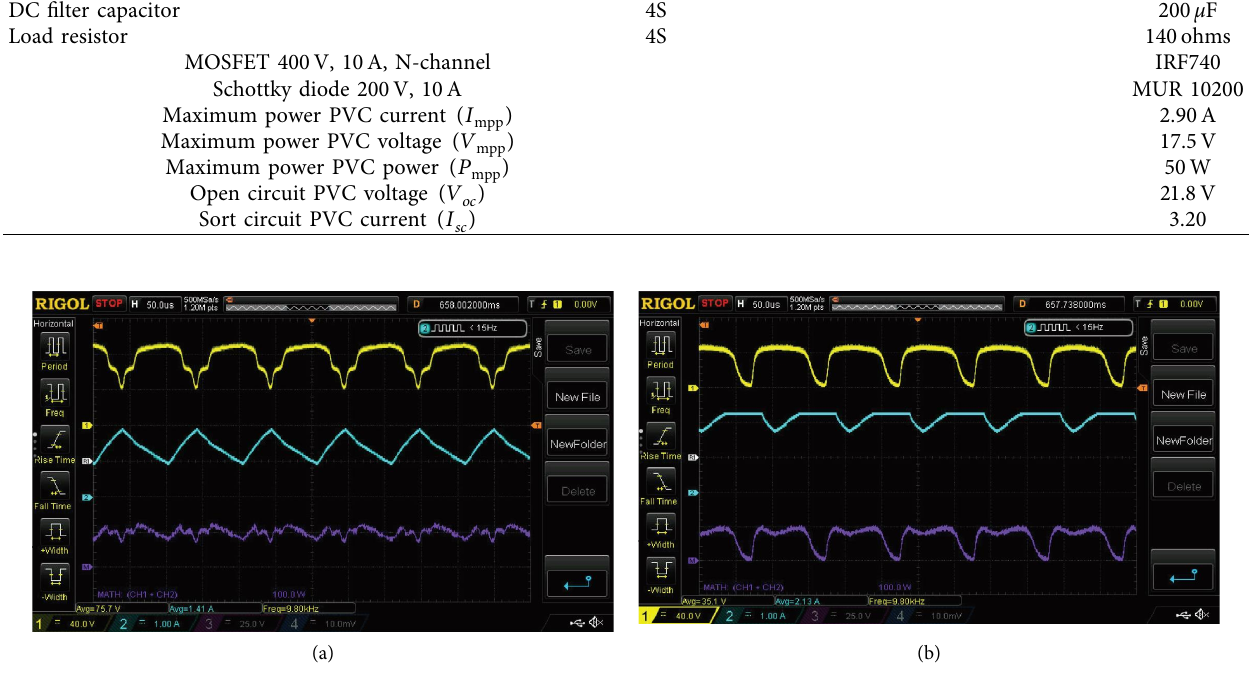
Figure 14: Experimental results for proposed GWO-ANFIS MPPT method for 4S confguration. (a) Pattern 1. (b) Pattern